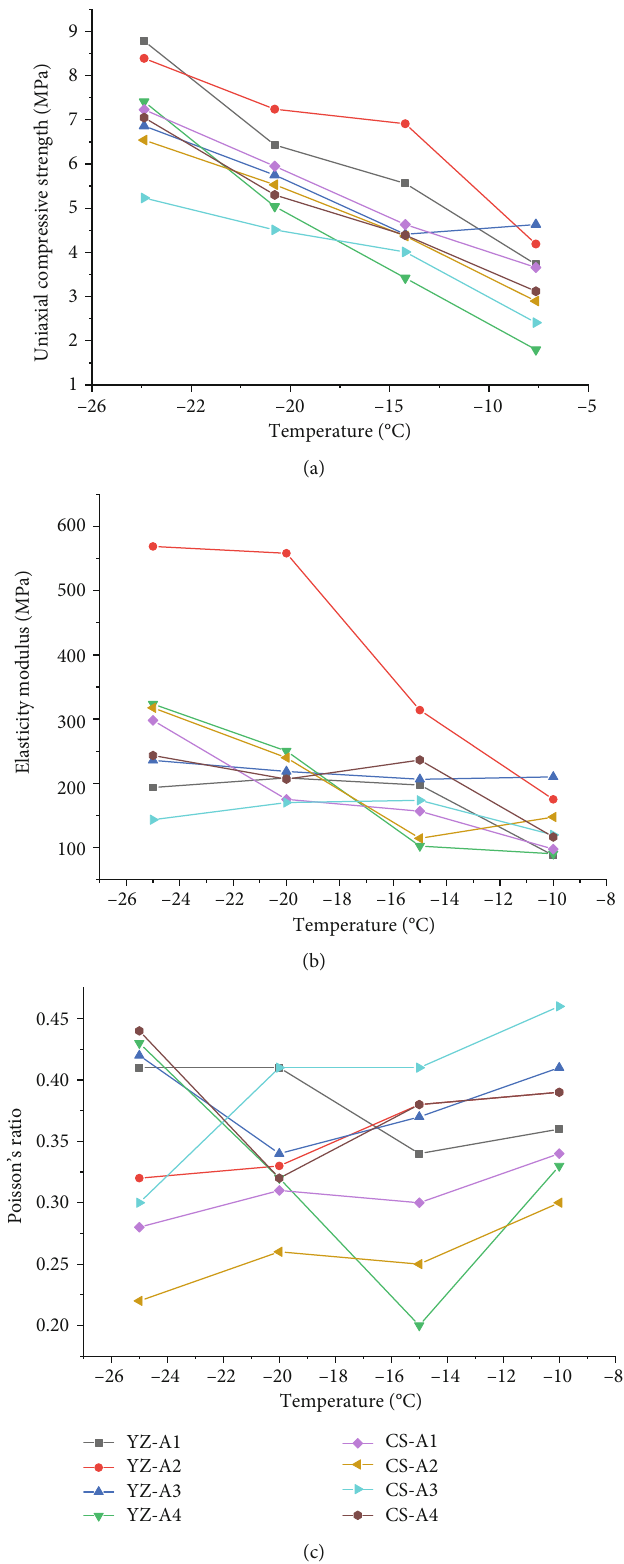
Figure 3: Variation curves of the (a) uniaxial compressive strength, (b) elastic modulus, and (c) Poisson ’ s ratio of the undisturbed and remolded frozen soils at di ff erent